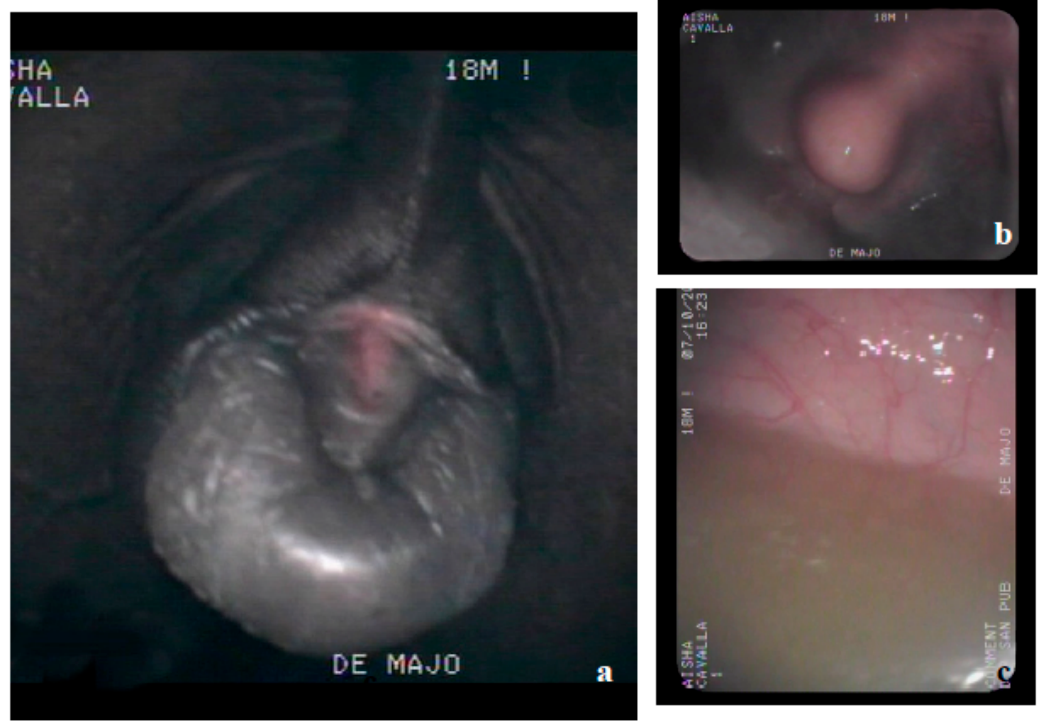
Figure 2. Video endoscopy of the horse. ( a ) Glans; ( b ) localization of internal urethral orifice and urethral meathus by video endoscope; ( c ) localization of bladder by video endoscope.